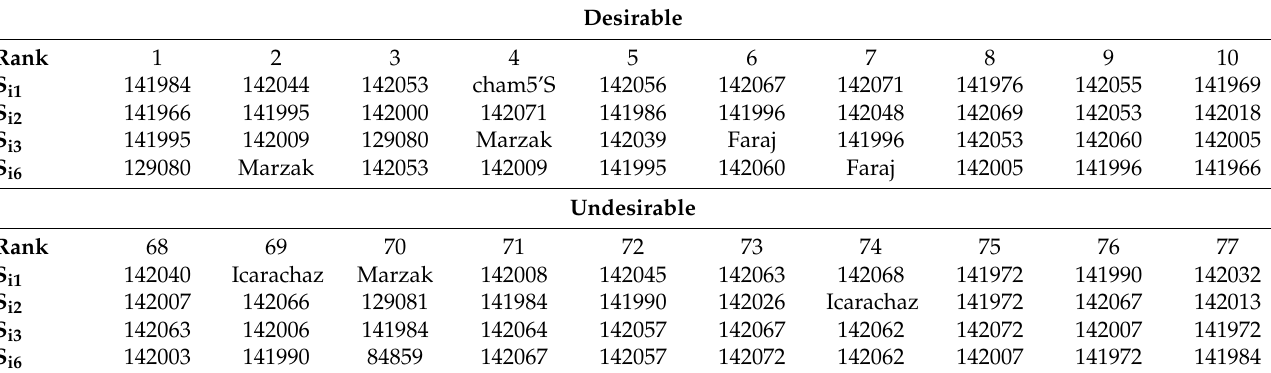
Table 7. Ranking of the best ten stable and the least ten stable durum wheat genotypes identified using four non-parametric stability